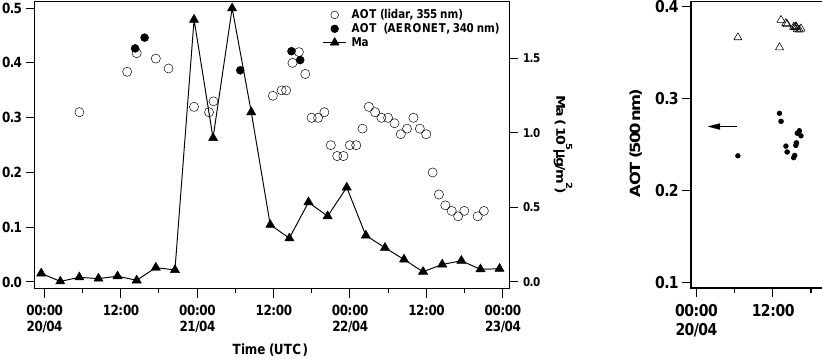
Fig. 5. Time series of the aerosol optical thickness (AOT) at 355nm Figure 5 (M. R. Perrone et al.) from lidar measurements (open dots) and of the ash total column tical thickness (AOT) at 500nm (full dots) and of the fine mode (Ma) simulated by FLEXPART at the lidar site (full triangles). fraction (open triangles) from AERONET sun/sky photometer mea- Full dots represent the aerosol optical thickness at 340nm from AERONET sun/sky photometer measurements.